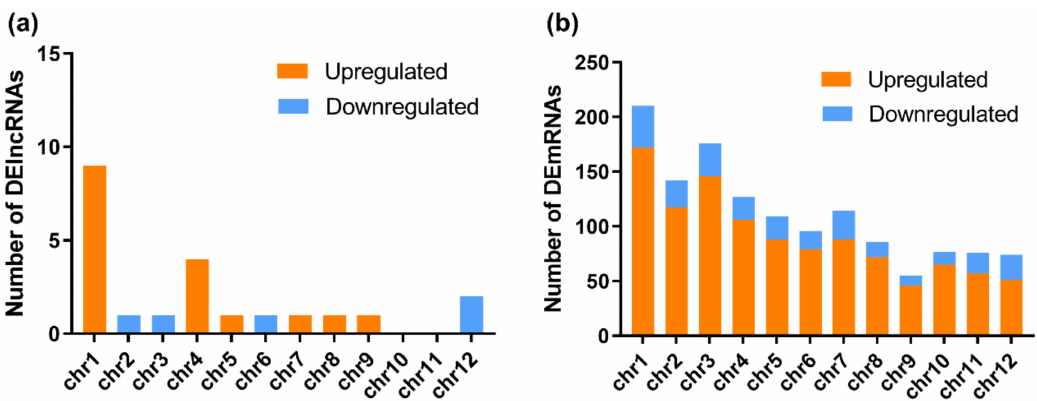
Figure 2. Chromosomal distributions of DElncRNAs and di ff erentially expressed mRNAs (DEmRNAs). The numbers of DElncRNAs ( a ) and DEmRNAs ( b ) on each chromosome are shown. Orange represents upregulation, while blue represents